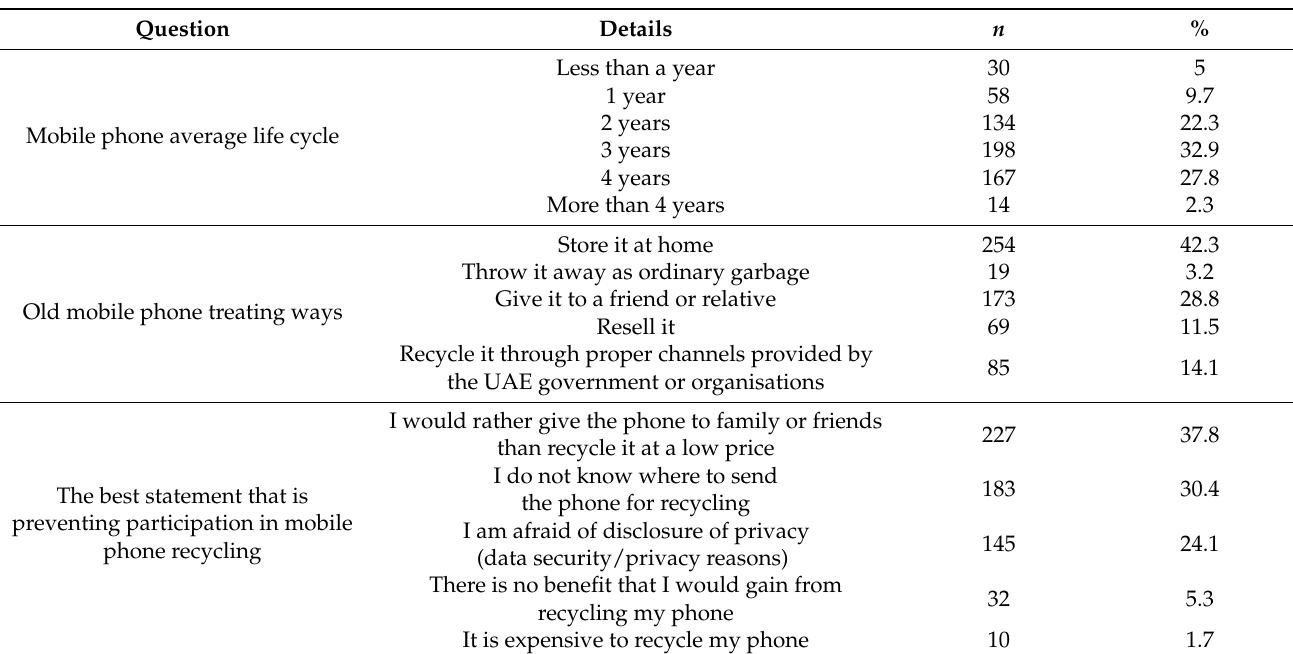
Table 10. Responses to mobile phone treatment